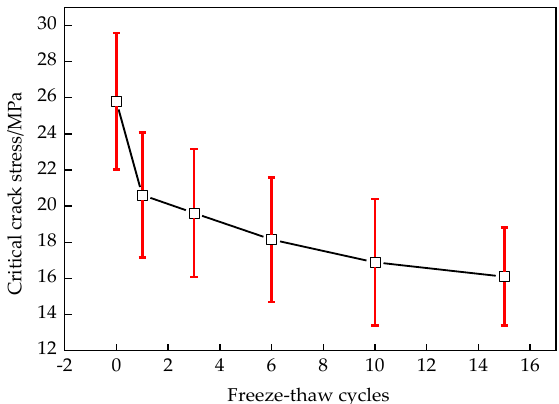
Figure 17. Change of elastic modulus.